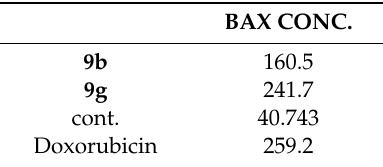
Figure 3. Bcl2 protein level (ng/mL) and BAX/BCL2 ratio of MCF-7treated with IC 50 of compound 9b (19.8 µg/mL) and IC 50 of 9g (26.2 µg/mL) compared to untreated cells and cells treated with reference drug Doxorubicin. p < 0.05 in 9b and 9g.